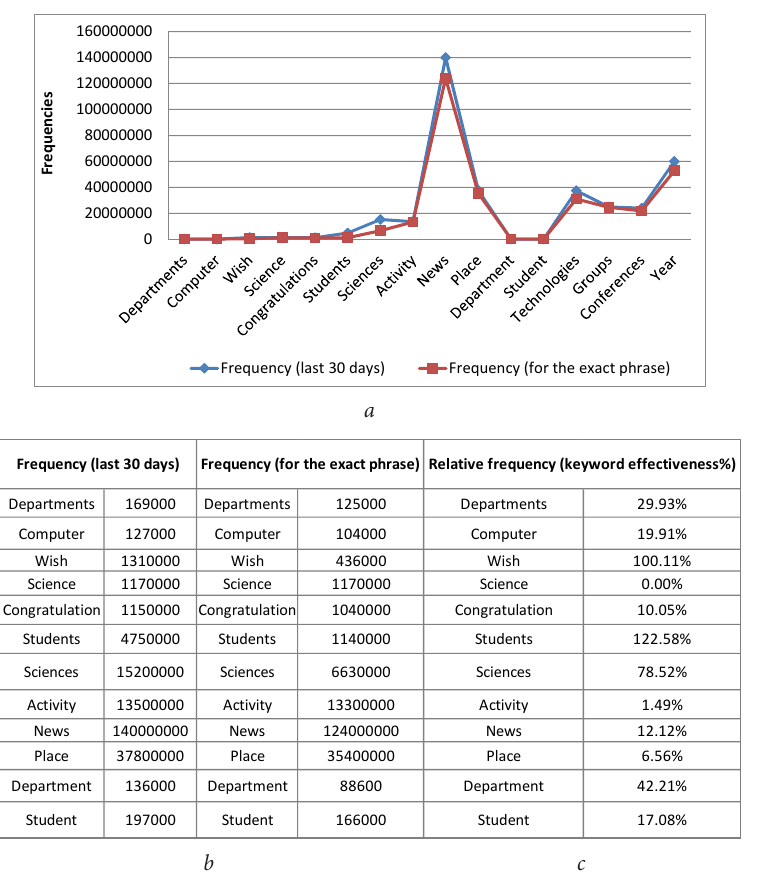
Fig. 3. Data obtained as a result of a request in Google Search: a – frequency graph; b – table values of frequencies (for the last 30 days and according to the exact phrase); с – relative frequency (keyword efficiency, %)